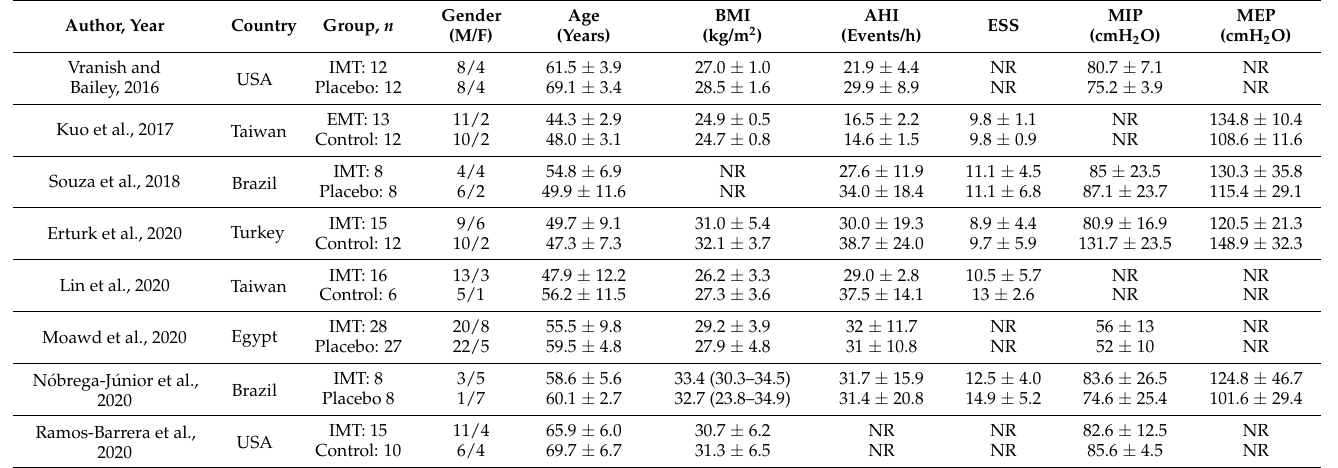
Table 1. Characteristics of included studies.